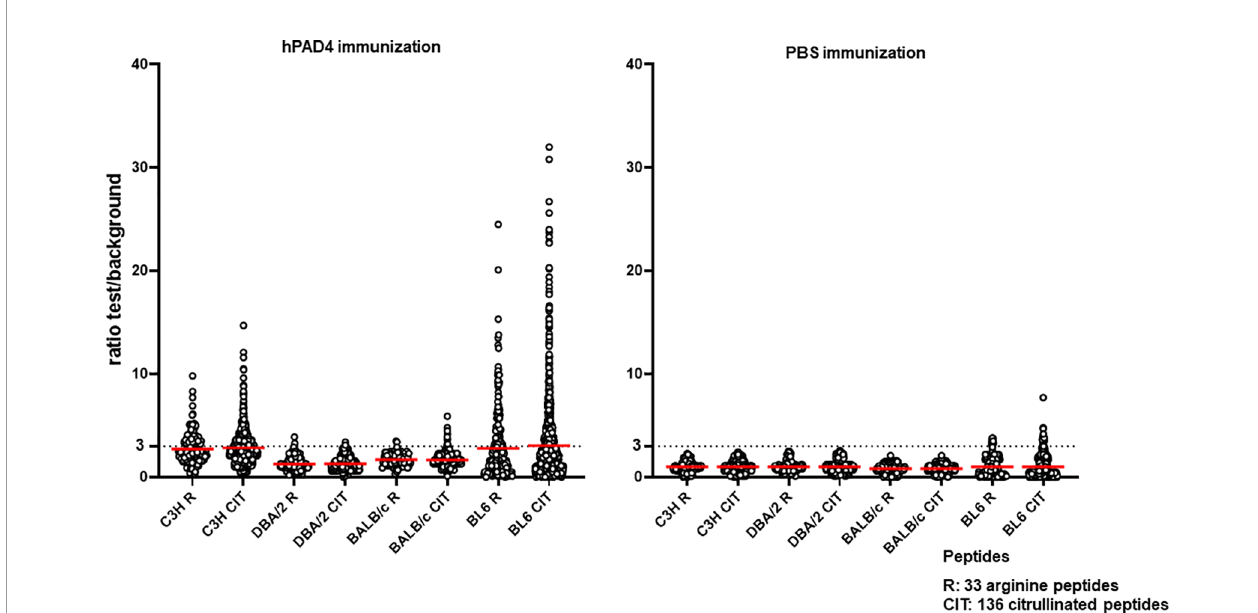
FIGURE 5 | Anti-arginine and citrullinated IgG responses in each mouse strain immunized with hPAD4 or PBS. A ratio test/background was calculated for each arginine (R) and citrulinated peptide (CIT). A positive serum was de fi ned by a ratio higher than